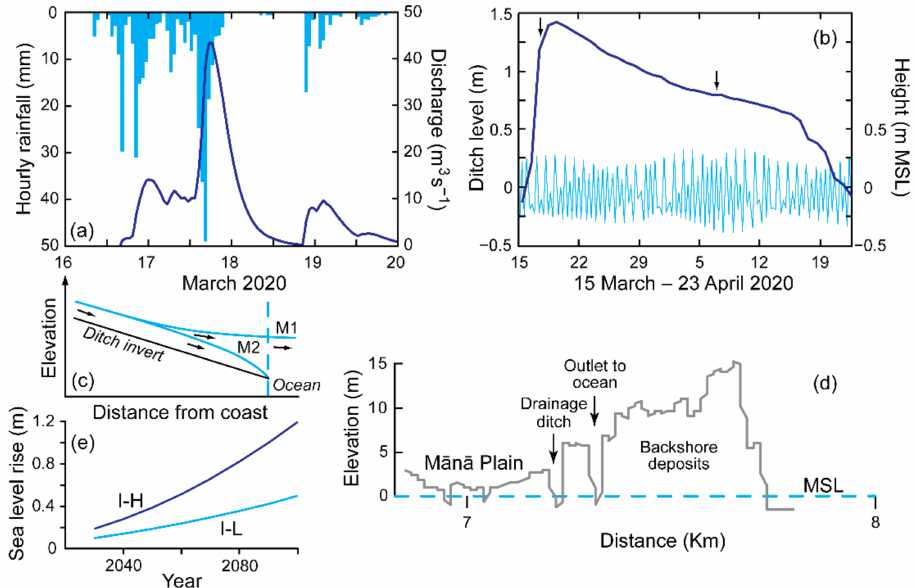
Figure 5. ( a ) 16–20 March 2020 hourly rainfall at Pu‘u ‘ ¯Opae (see Figure 4a for gauge location) and HEC-HMS simulated hydrograph for Nahomalu Stream. ( b ) Water level in the drainage ditch system at the Kawai‘ele pumping station and NOAA tide predictions for Port Allen, Kaua‘i (Station 1611347). Arrows indicate dates when the ditch plug was removed to permit storm runoff to flow into Kinikini Ditch under the influence of gravity, and (second arrow) subsequently replaced. ( c ) Schematic hydraulic curves describing the shape of the water surface profile of gradually varied, sub-critical flow in a mildly sloping channel, when discharge in the channel is high and: M2, the normal depth in the channel is at a higher elevation than the water surface at the coast; and M1, the water level at the coast is at a higher elevation than the normal depth in the channel. ( d ) Ground surface elevation in the vicinity of Kinikini Ditch (see Figure 1 for section location). ( e ) Projections of SLR, based on the intermediate-low (I-L) and intermediate-high (I-H) scenarios used in the West Kaua‘i Community Vulnerability Assessment [1,55]. SLR of ~1 m is considered likely by 2100 and is utilized as a mid-to-late century projection for planning